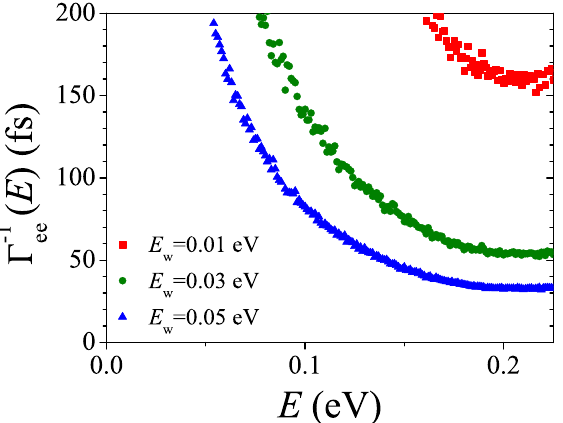
Figure 9. The time constant by the elastic e-e scattering is given. The energy is referenced from that of the L valley bottom. Adapted with the permission from [12], copyright Journal of the Physical Society of Japan,